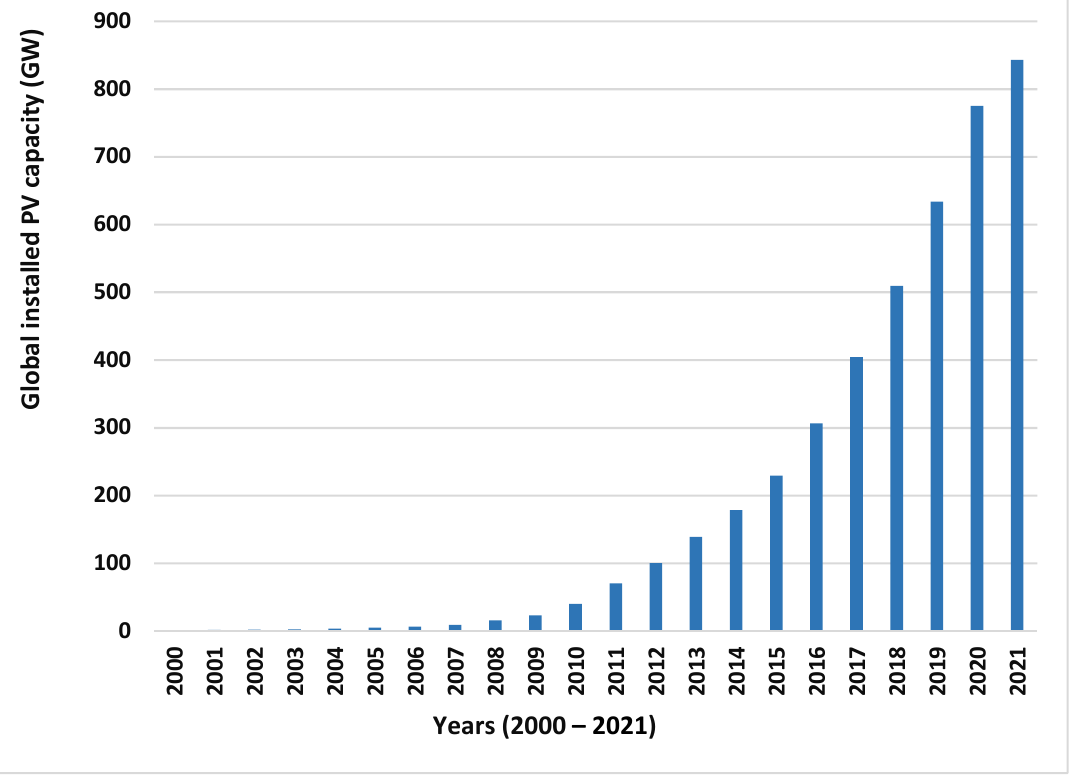
Table 1. PV power performance